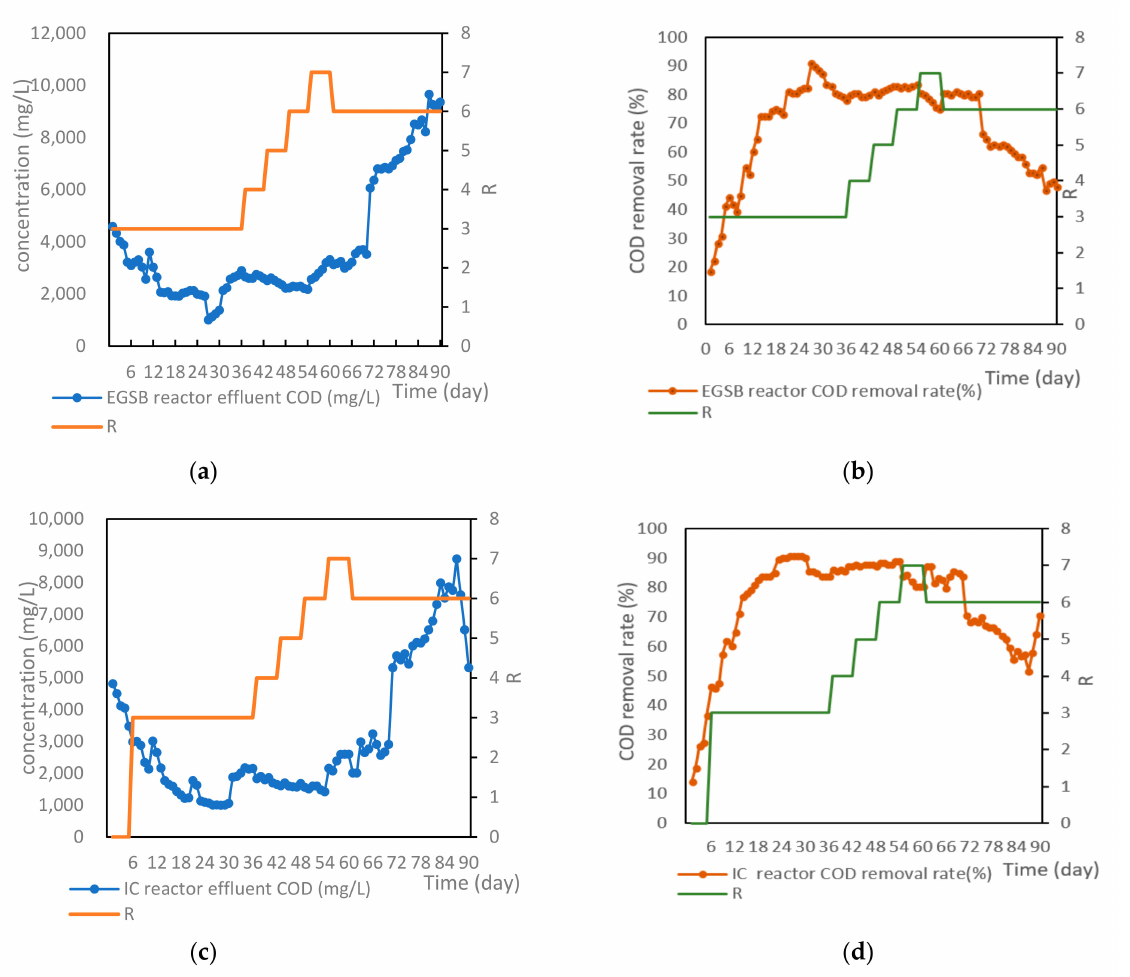
Figure 11. The effect of reflux on COD removal performance of the two reactors. ( a ) Relationship between R and COD of EGSB effluent. ( b ) Relationship between R and COD removal of EGSB. ( c ) Relationship between R and COD of IC effluent. ( d ) Relationship between R and COD removal of